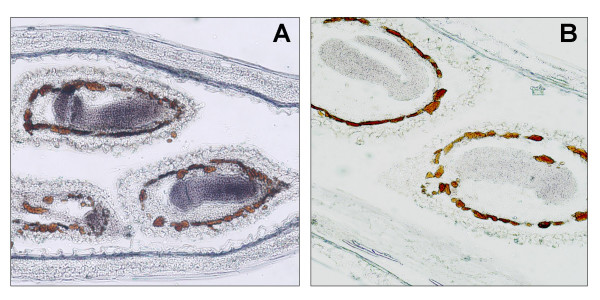
In-situ hybridization analysis of a seed-specifically expressed gene. Seed-specific transcript labelling of embryos at the late torpedo stage as shown by in situ hybridization of transverse sections of Arabidopsis siliques probed with digoxigenin-labelled At5g22470 mRNA, viewed under bright-field optics.